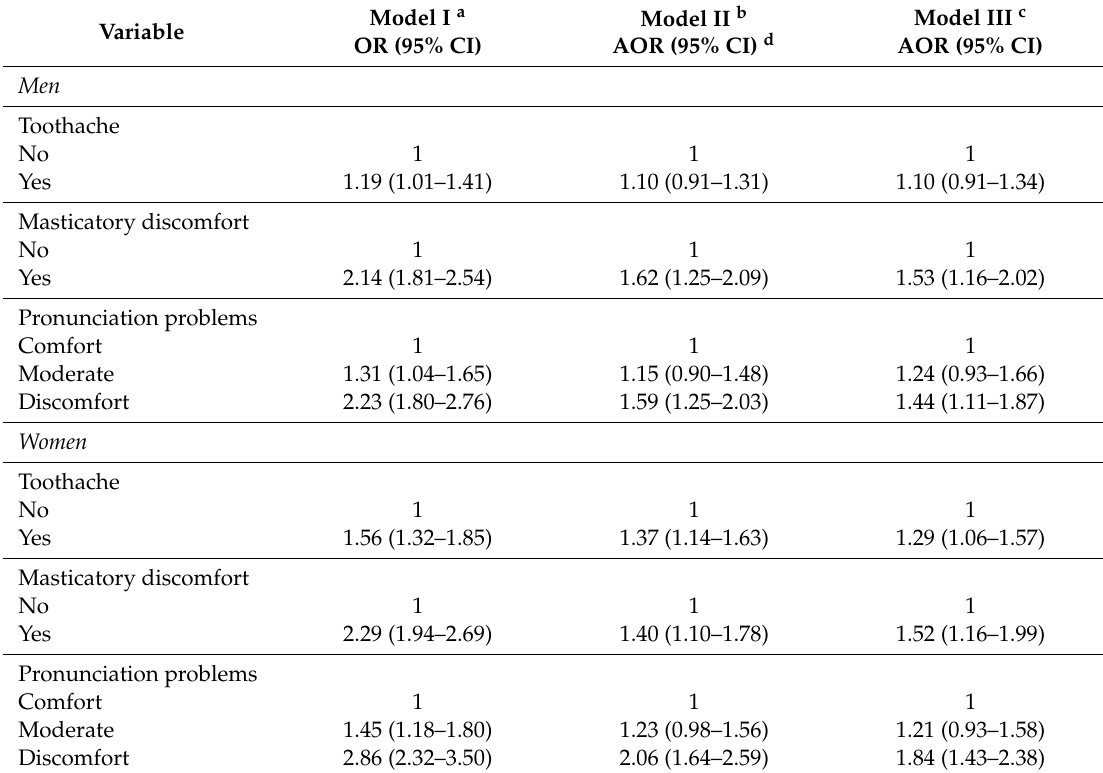
Table 4. Subgroup analysis for association between oral discomfort problems and health-related quality of life (EQ-5D score) by